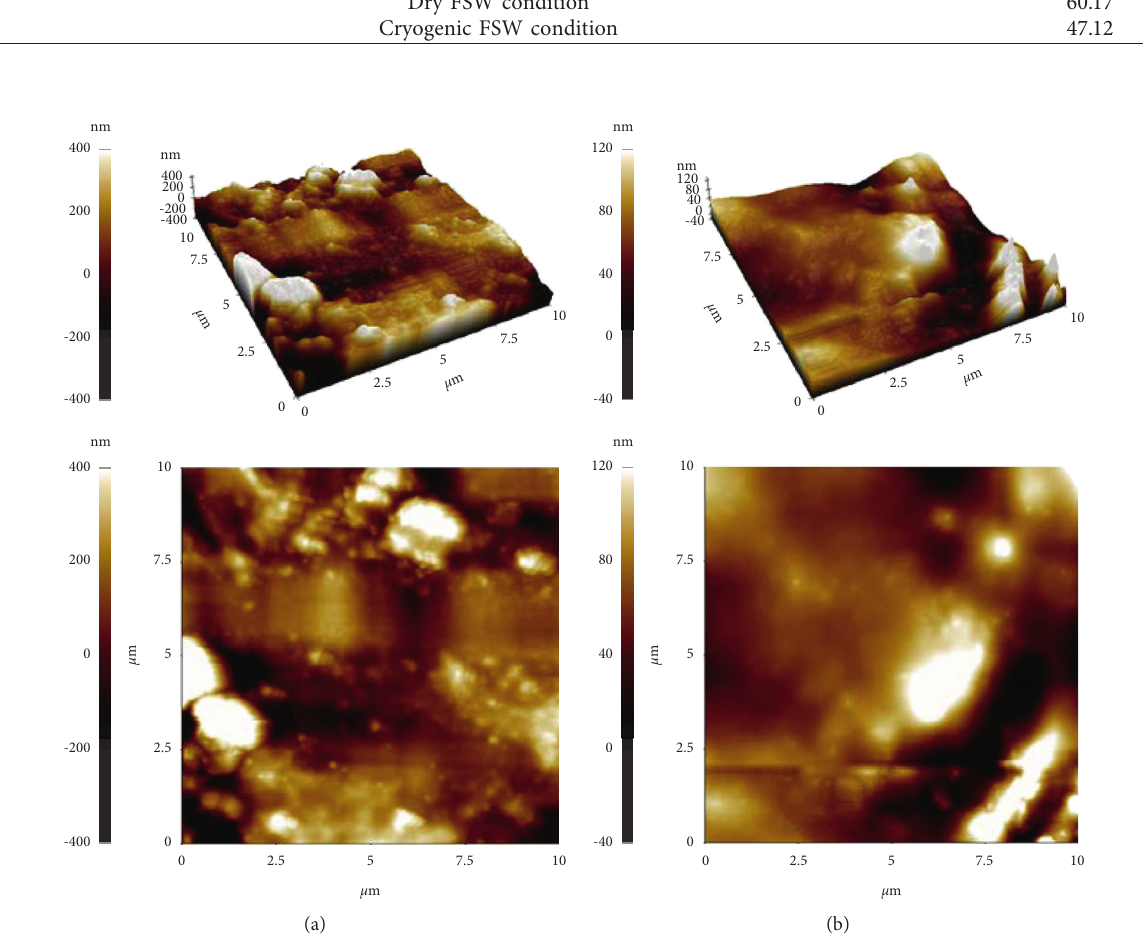
Figure 21: Atomic force microscopy of (a) dry and (b) cryogenic friction stir-welded AA 7075 samples. Table 12: Topographical analysis of AISI 4340 in dry and cryogenic Table 13: Residual stress (compressive) analysis of AA 7075 friction stir welding surfaces. friction stir-welded Broaching Roughness factor (nm) Dry 238 Cryogenic 117